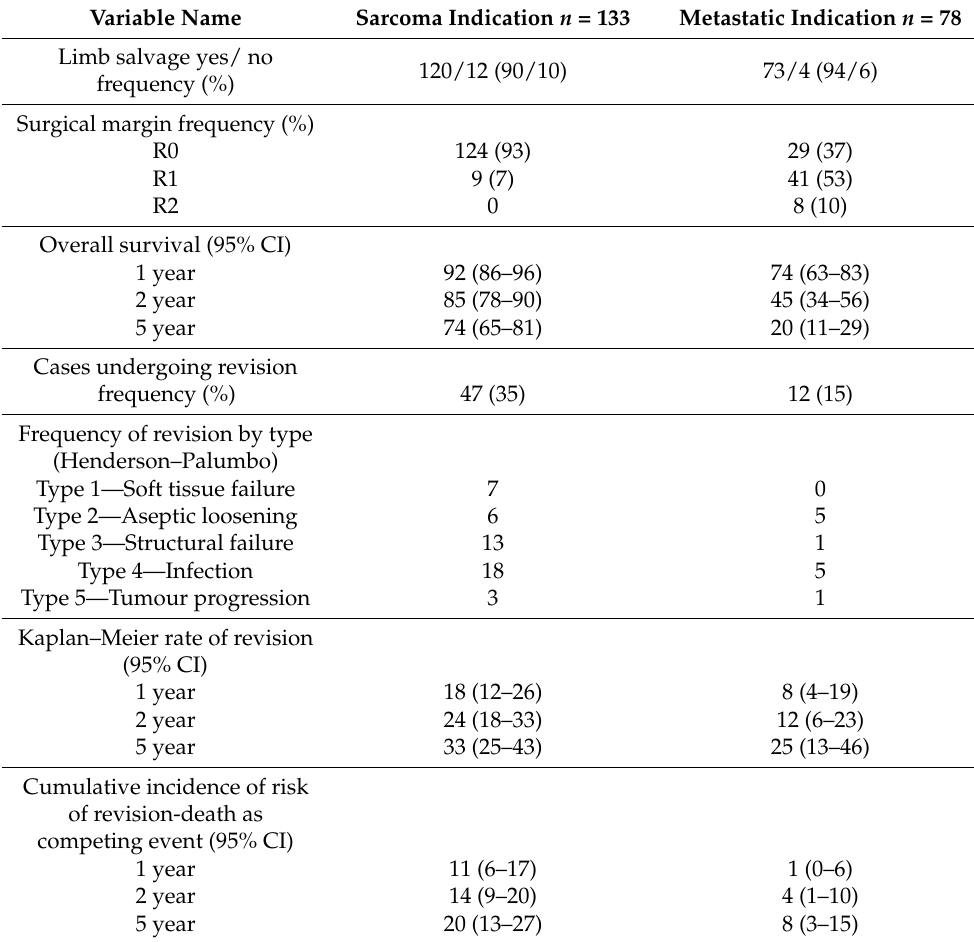
Table 3. Results by indication